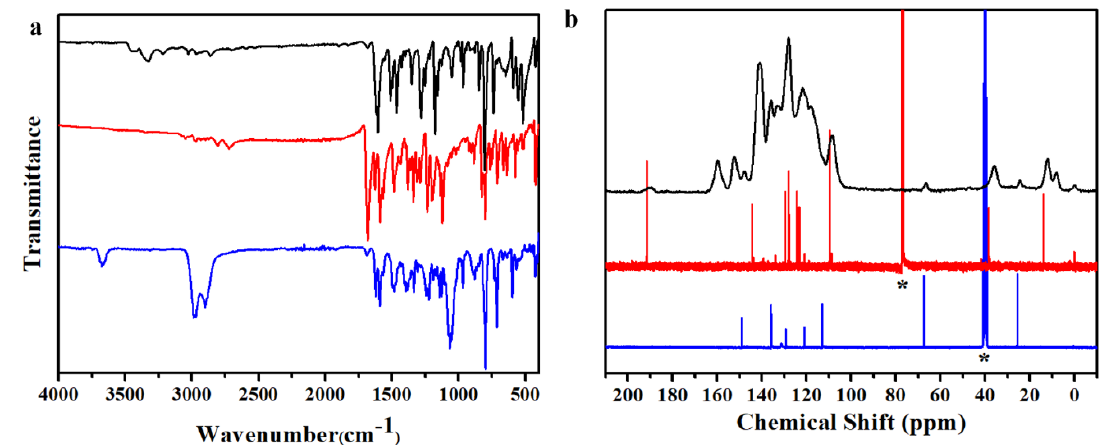
Figure 1. ( a ) FT-IR spectra of 5,10,15,20-tetrakis(4-aminophenyl)porphyrin (blue curve), 3,6-diformyl-9-ethylcarbazole (red curve) and COF-K (black curve); ( b ) 13 C CP/MAS NMR spectra of COF-K (black curve), 3,6-diformyl-9-ethylcarbazole (red curve), 5,10,15,20-tetrakis(4-aminophenyl)porphyrin (blue curve). Note: * represents solvent peak .